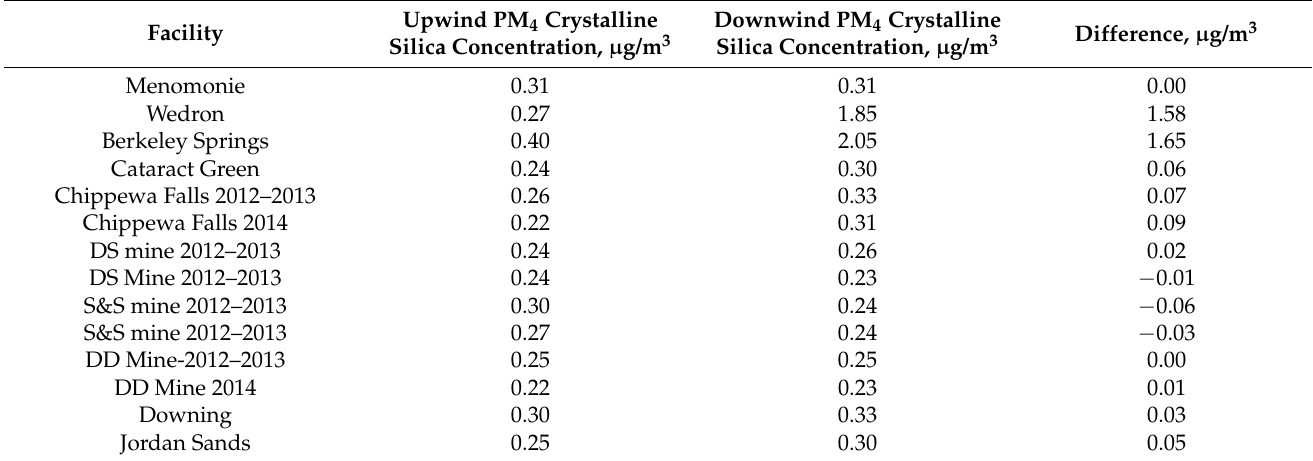
Table 4. Upwind–downwind concentration